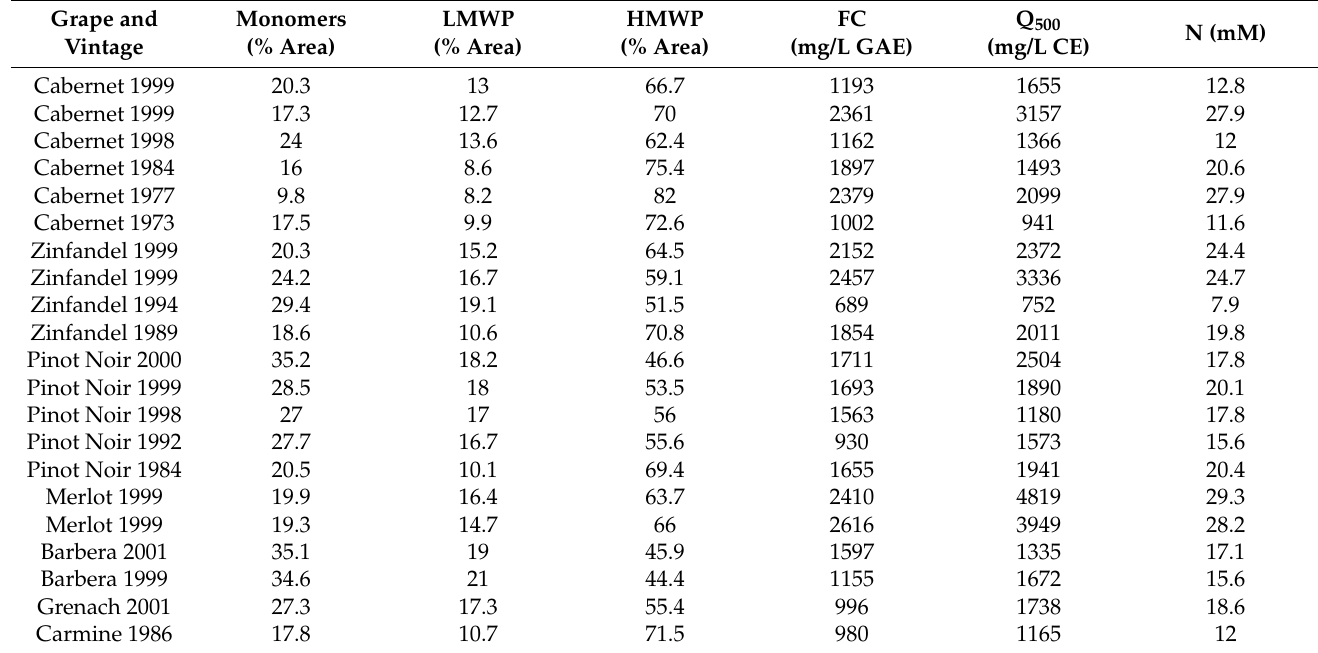
Table 6. Levels of wine phenolic monomers, low molecular-weight polymers (LMWP) and high molecular-weight polymers (HMWP) as determined by using HLPC and parameters characterizing AOA given by Folin–Ciocalteau total phenols, CV response (Q500) and overall AOA (N) See [25] for details.